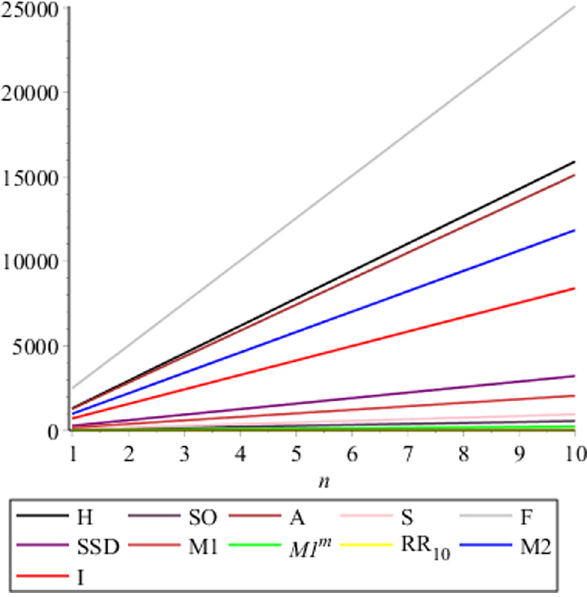
Figure 3: Comparison of topological invariants by applying polyno - mials for TM - TCNB at x = 1 and y = 1.